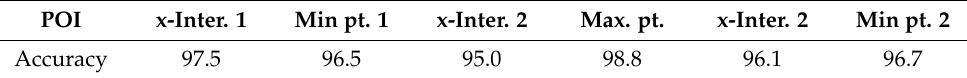
Table 4. Accuracy of the traditional LK method with respect to the MTS movements.